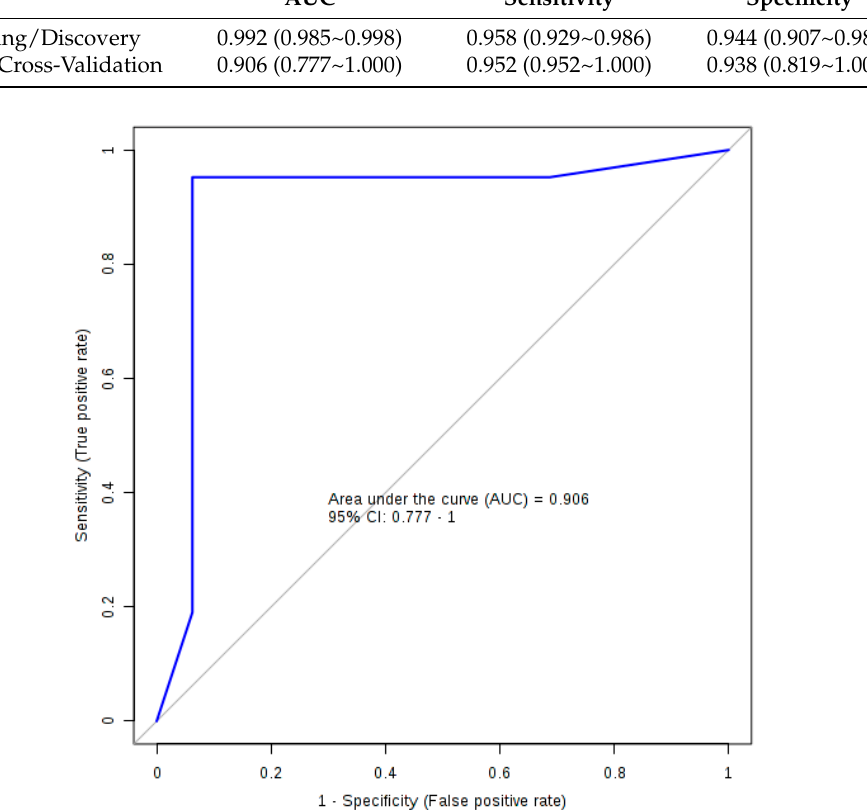
Figure 2. The ROC plot for the logistic regression diagnostic algorithm.